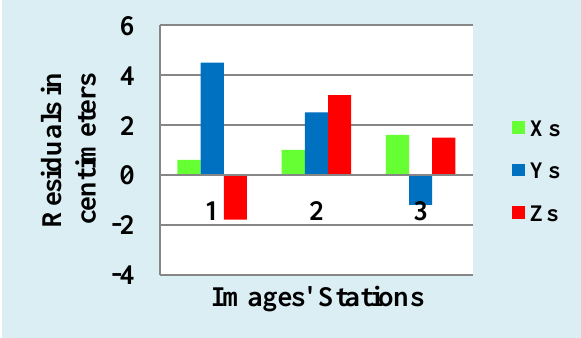
Figure 2. Shows the position residuals of images taken in the